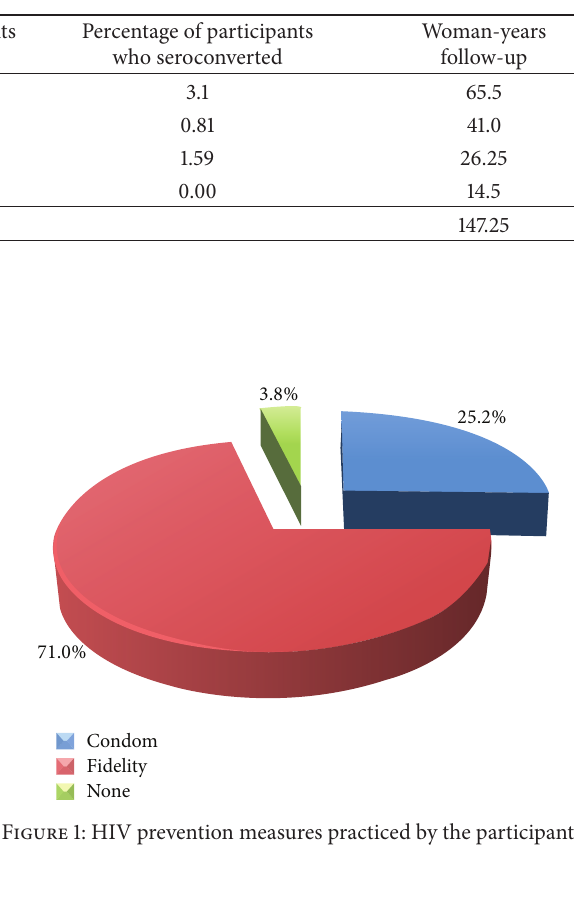
Table 3: Incidence of HIV seroconversion in the seven healthcare facilities.